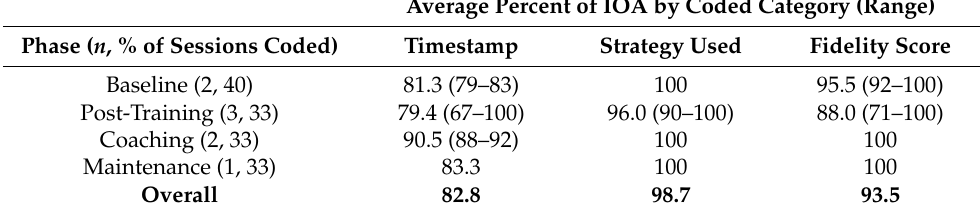
Table 1. Interobserver Agreement by